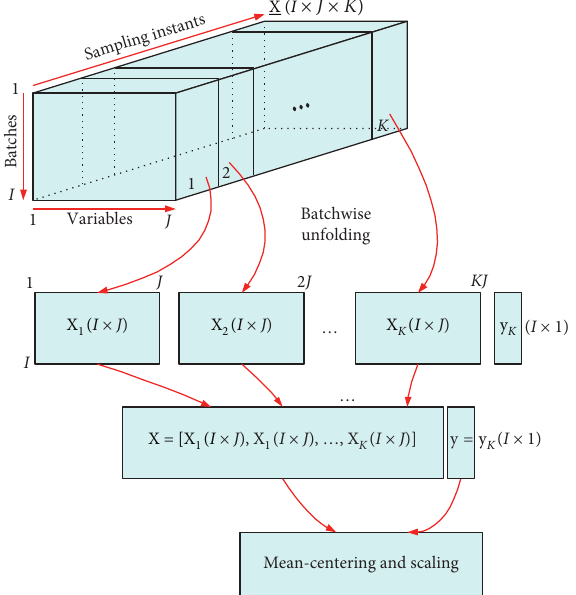
Figure 1: Batchwise unfolding of three-way data